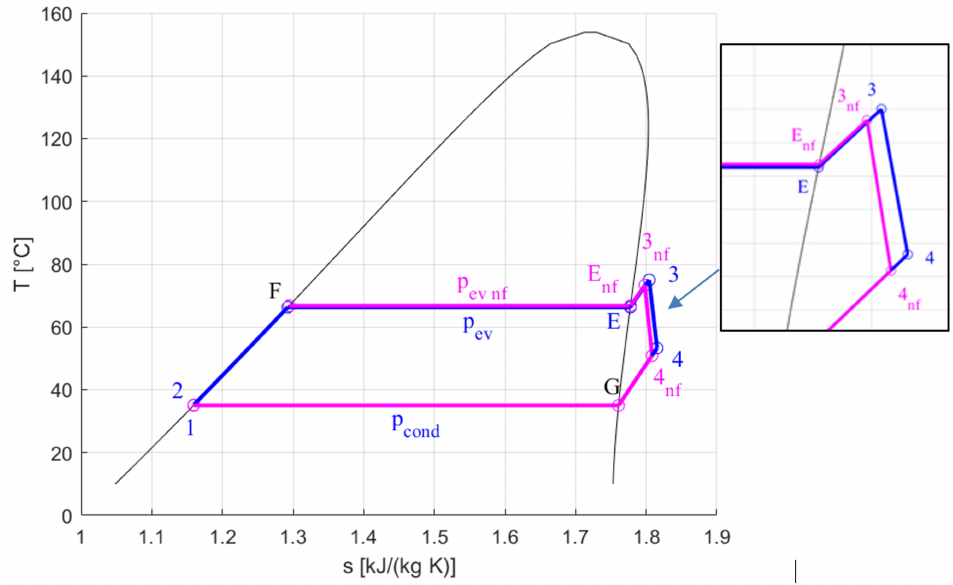
Figure 6. Comparison between the expansion of the pure R245fa (blue line) and of the R245fa/MIL101 nanofluid (pink line) in the T-s diagram ( T s , in = 100 ◦